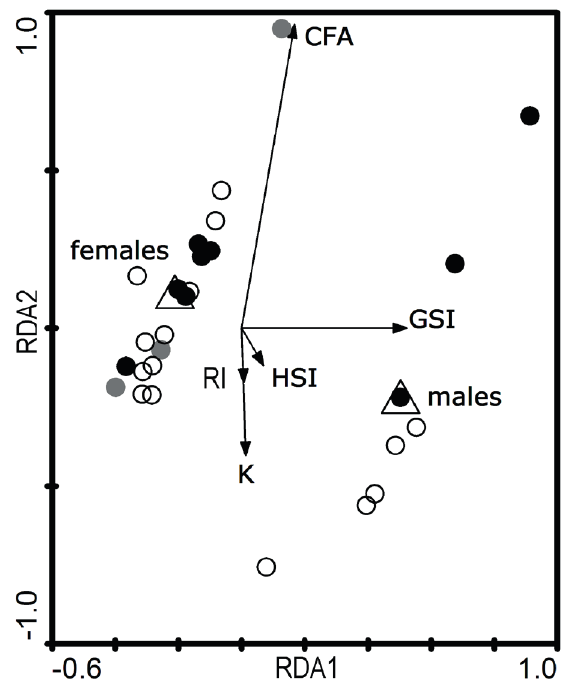
Figure 3. Partial Redundancy Analysis (RDA) showing the relationship of fl uctuating asymmetry (CFA) with four physiological indexes (GSI, HSI, RI, and K) of male and female Orthopristis ruber . ⚪ =Urca; ⚫ = Rio- Niterói Bridge; ⚫ =Paquetá; Δ= grouping of male and female.